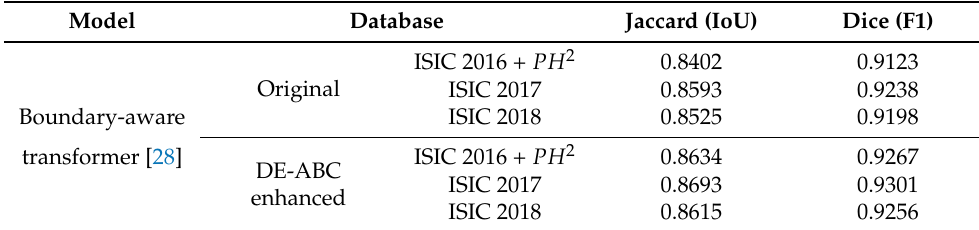
Table 2. Experimental results of boundary-aware transformer (BAT) model.